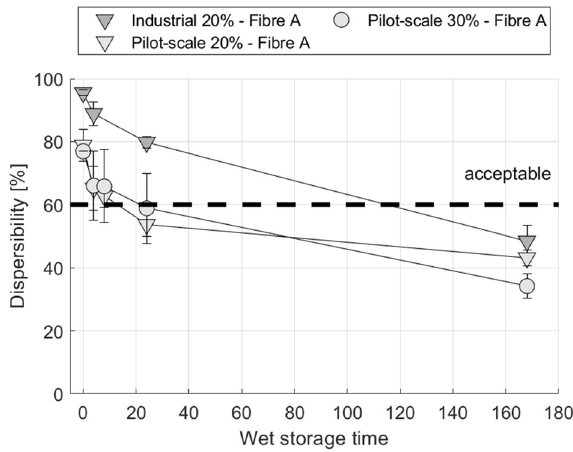
Figure 5. Wet wipe dispersibility after storage in water. Wipes were made in laboratory pilot-scale production (cf. Table 2 P.AB.20, P.AB.30) and industrial pilot production (cf. Table 3 I.AB.20), using the same fibres. All products show the same dispersibility ageing (deterioration in dispersibility). Error bars represent one standard